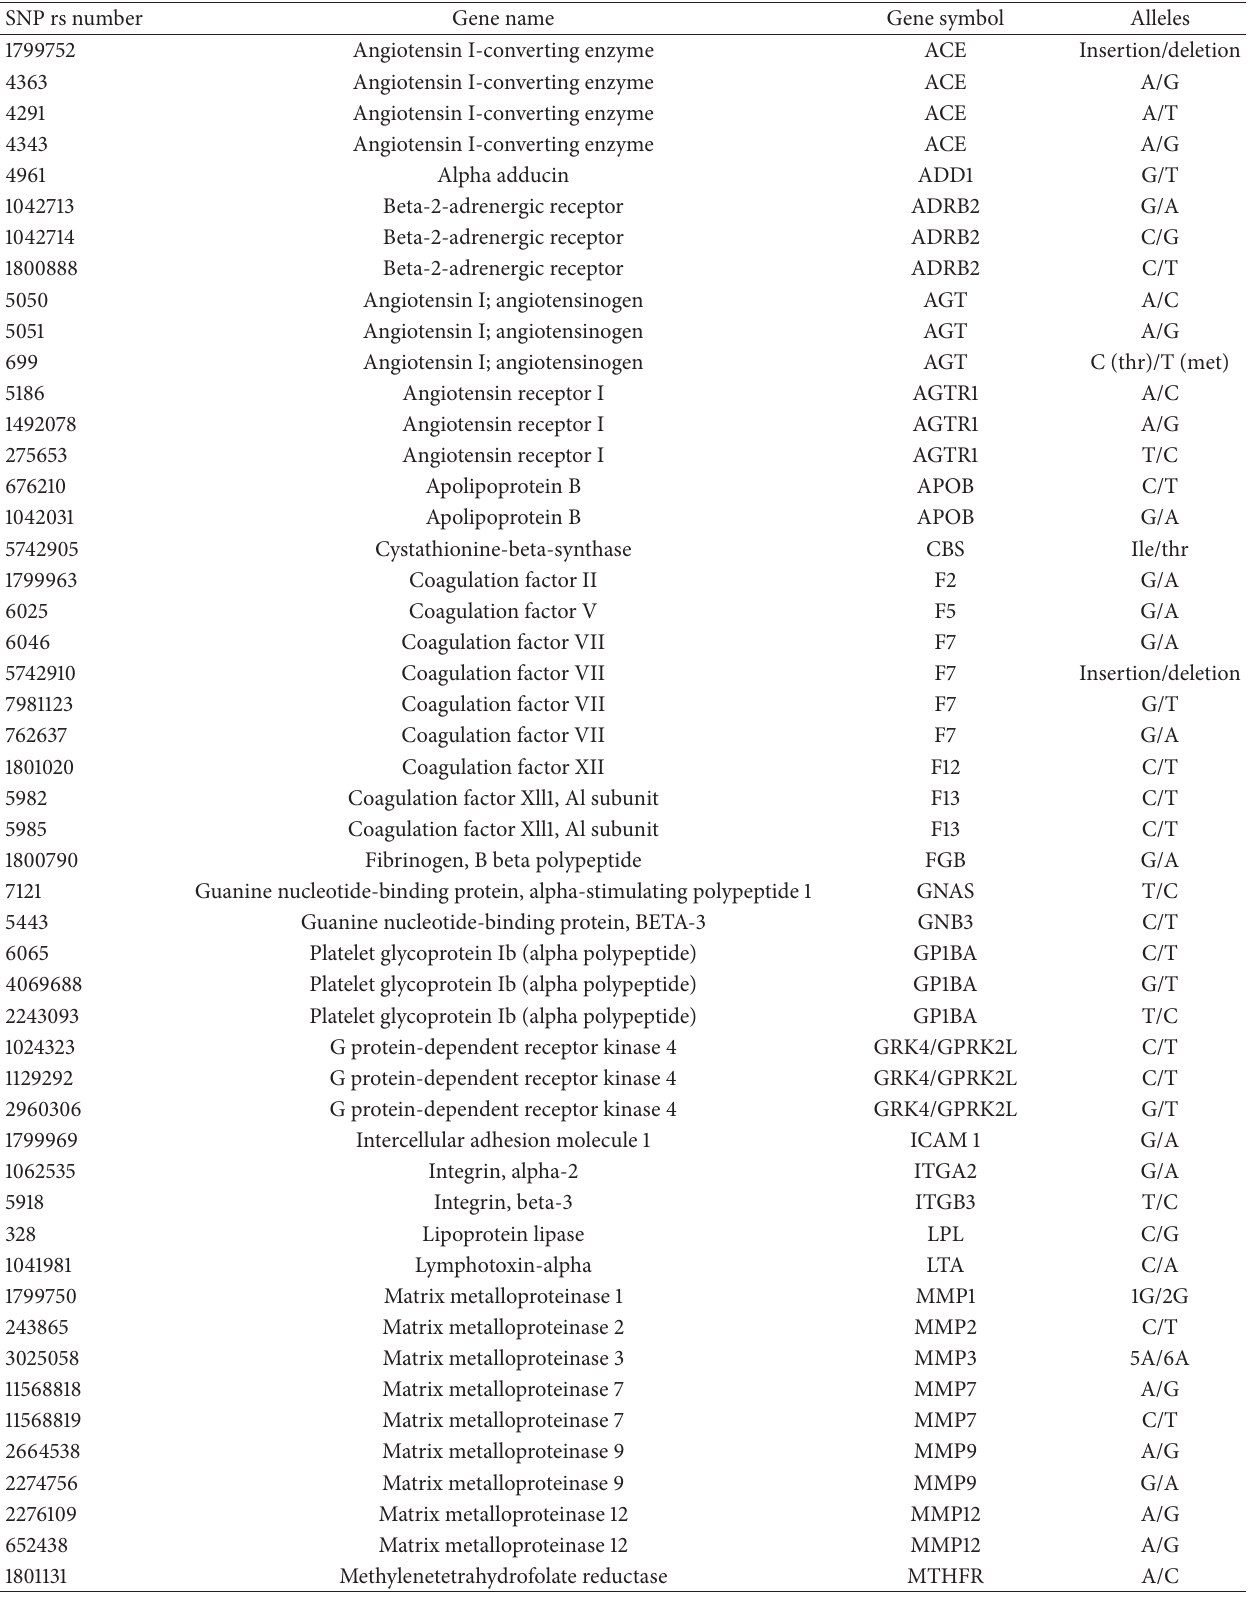
Table 1: Genetic variants